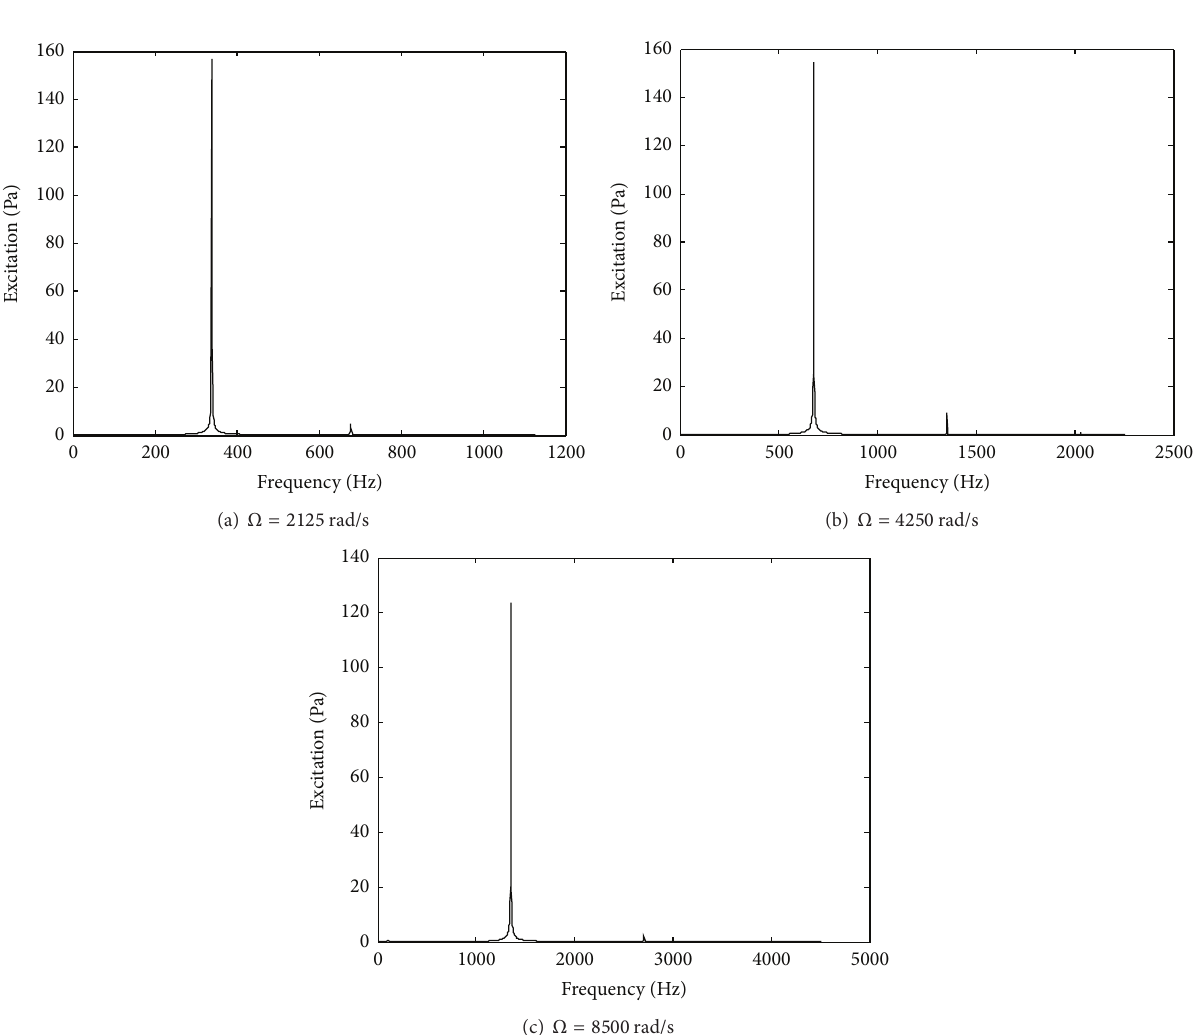
Pressure distributions along stationary engine case